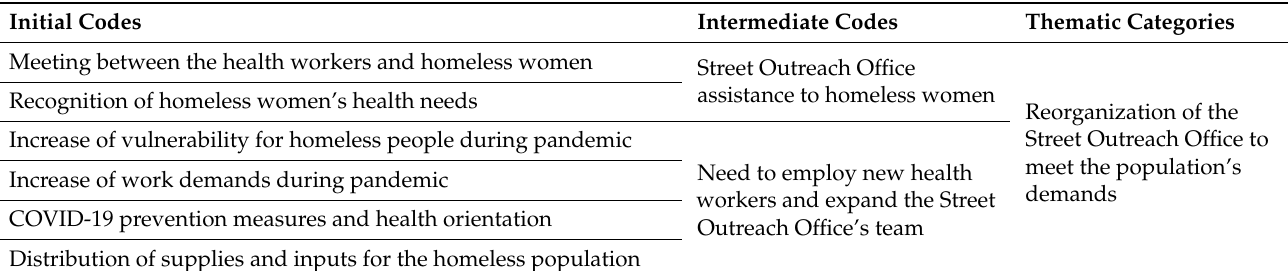
Table 1. Coding data. Ribeir ã o Preto—SP, Brazil,